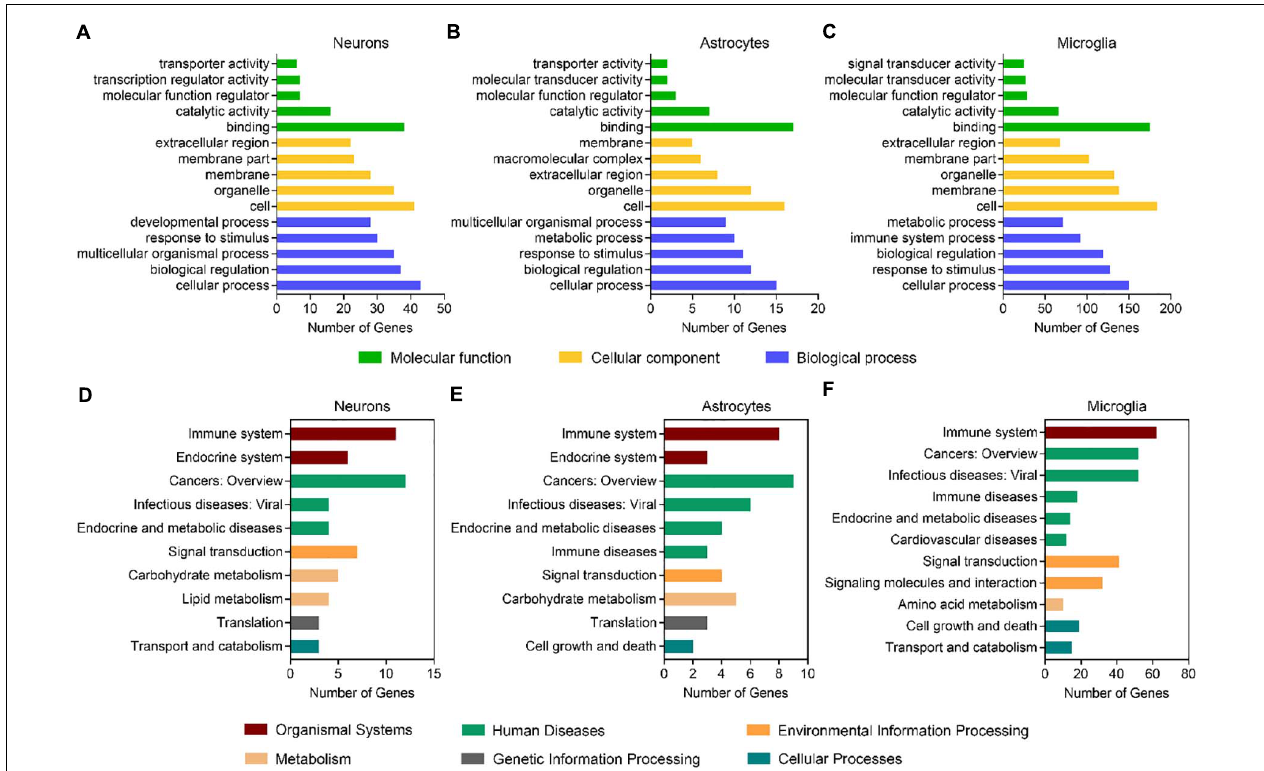
FIGURE 2 | Sexually dimorphic genes exhibit similar annotation patterns in neurons, astrocytes, and microglia. (A–C) GO analysis of DEGs (male versus female) in neurons (A) , astrocytes (B), and microglia (C) . Green bars represent the molecular function, yellow bars represent the cellular component, and blue bars represent the biological process. (D–F) KEGG analysis of DEGs (male versus female) in neurons (D) , astrocytes (E), and microglia (F) . Red bars represent organismal systems, green bars represent human diseases, orange bars represent environmental information processing, flesh color bars represent metabolism, gray bars represent genetic information processing, and blue bars represent cellular